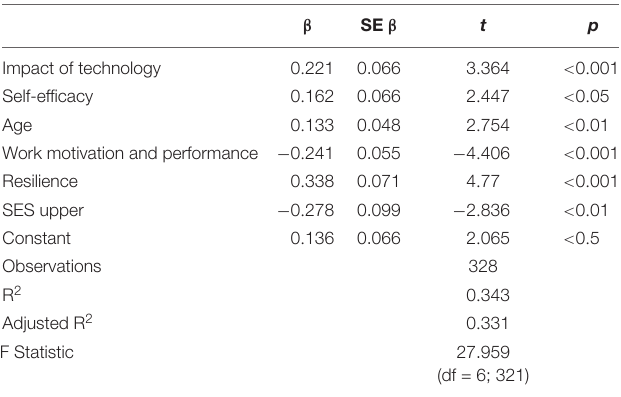
TABLE 5 | Summary of regression analysis predicting emotional well-being.